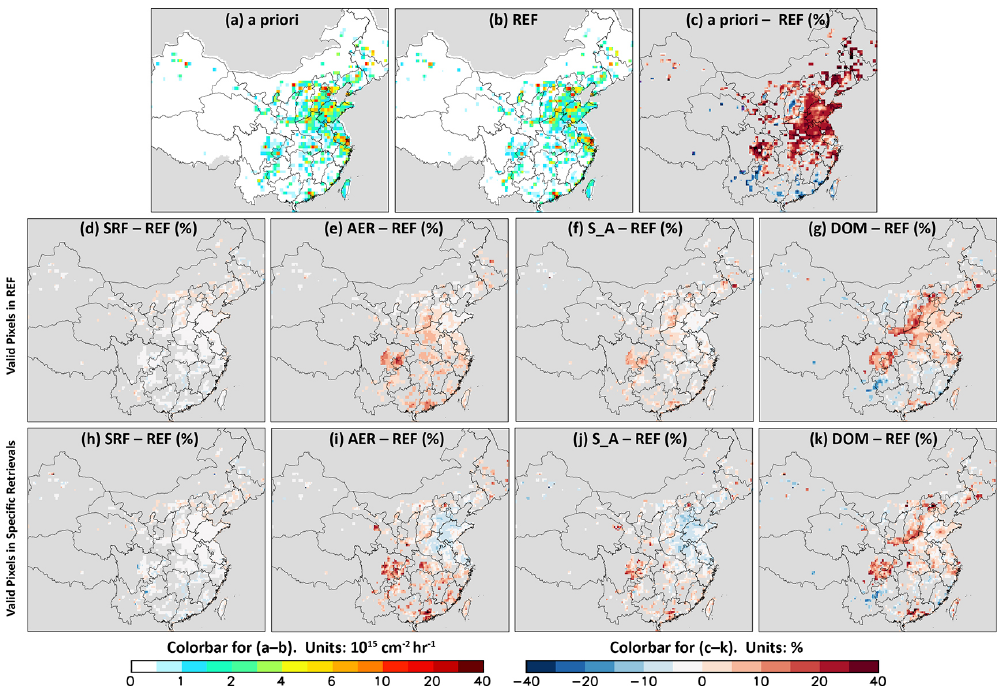
Figure 13. (a) The a priori anthropogenic emissions of NO x on a 0.25 ◦ long. × 0.25 ◦ lat. grid. (b) The a posteriori emissions constrained by case REF. (c) Differences between a priori and REF as a percentage fraction of REF. (d–g) Changes in a posteriori emissions from REF to other cases as a percentage fraction of REF; OMI pixels are selected only when valid in case REF. (h–k) are similar to (d–g) but with respect to pixels valid in individual retrieval approaches. In (c–k) , areas with emissions below 0.5 × 10 15 cm − 2 h − 1 are masked. Provincial boundaries of China are shown. Values outside the upper (lower) bound of color intervals are shown in black (purple). Color intervals are nonlinear to better present the data range; an interval without labeling represents the mean of adjacent two